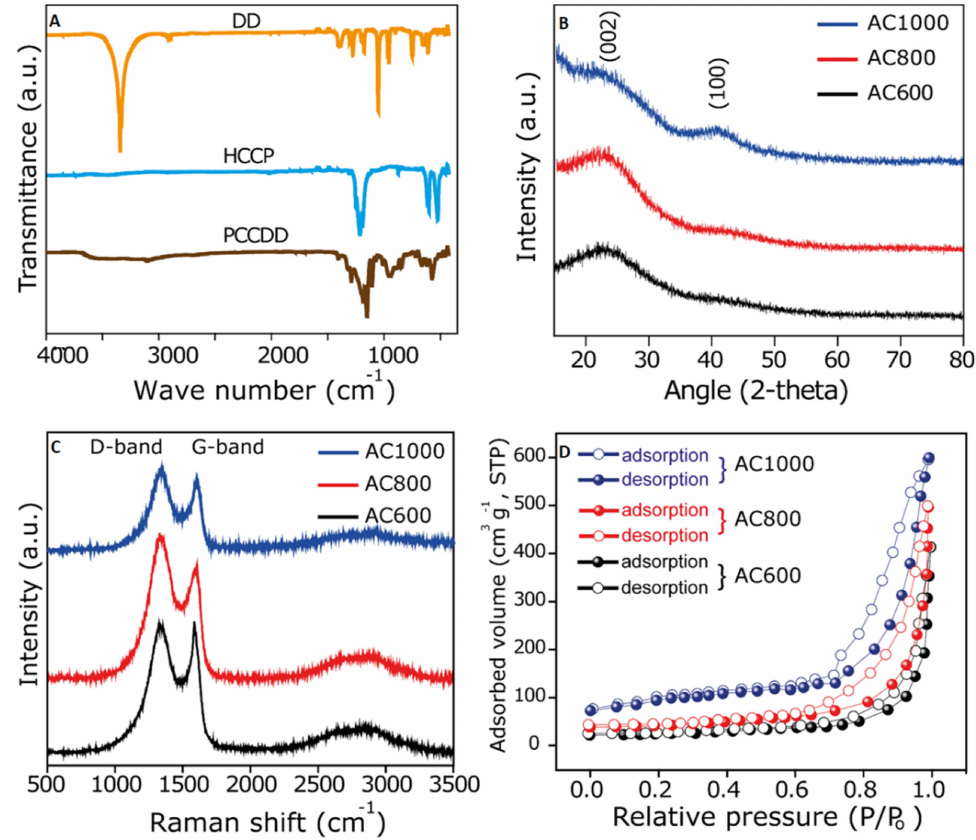
Figure 1. ( A ) FTIR analysis of DD monomer, HCCP monomer, and PCD polymer. ( B ) XRD, ( C ) Raman, and ( D ) N 2 absorption-desorption isotherms of SNPO-CPL-600 (black line), SNPO-CPL-800 (red line), and SNPO-CPL-1000 (blue line),